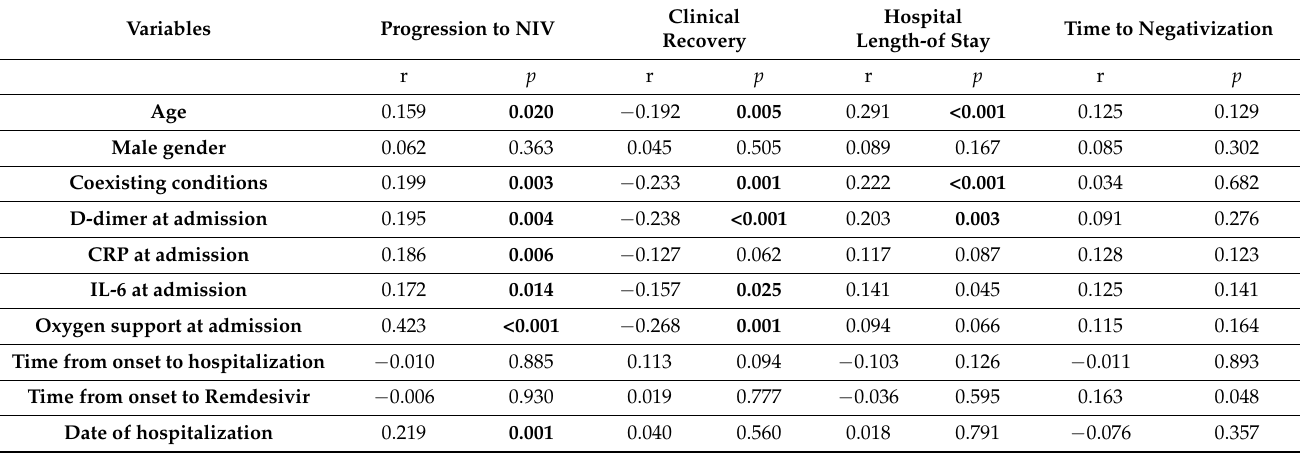
Table 3. Spearman/Pearson’s correlation coefficient matrix between patient’s demographic, clinical and laboratory features and (i) Progression to non-invasive ventilation (NIV); (ii) Clinical recovery, (iii) Hospital length-of-stay, (iv) Time to negativization of SARS-CoV-2 PCR on nasal-pharyngeal swab. A p < 0.05 (bold) was considered as statistically significant. Clinical Hospital Variables Progression to NIV Recovery Length-of